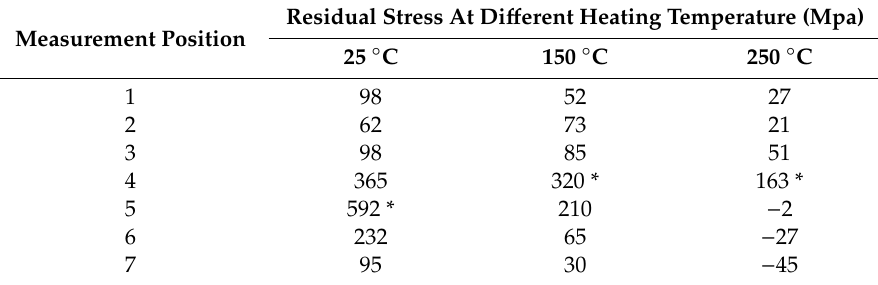
Table 10. Residual stress with di ff erent heating conditions.